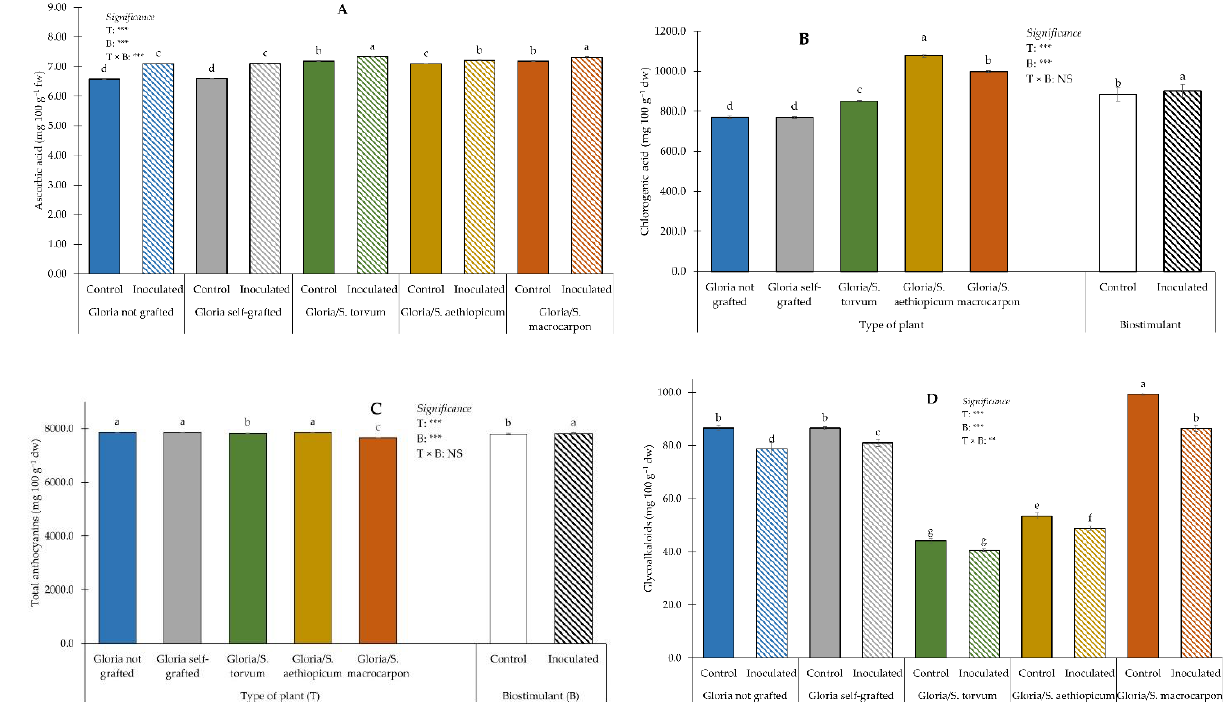
Figure 3. Influences of the type of plant and biostimulant application on ascorbic acid ( A ), chloro- genic acid ( B ), total anthocyanins ( C ) and glycoalkaloids ( D ). Mean values with different letters are significantly dissimilar at p ≤ 0.05, according to Tukey’s test. NS = not significant; ** = significant at p ≤ 0.01; ** * = significant at p ≤ 0.001. Bars indicate the means ± standard error.